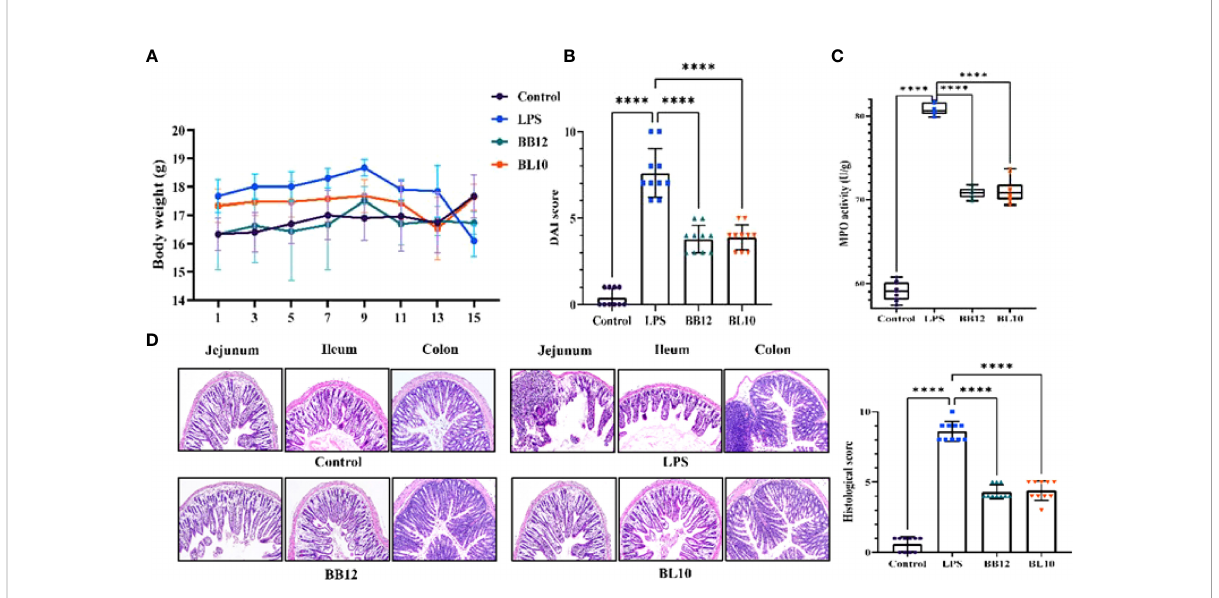
FIGURE 2 Effect of B longum BL-10 on LPS-induced intestinal immune injury. (A) Body weight; (B) DAI score; (C) MPO activity; (D) H&E staining (magni fi cation × 200) and colon histological score. All data are expressed as mean ± SD (n=10). Values with a different superscript letter (****) were signi fi cantly different at p <